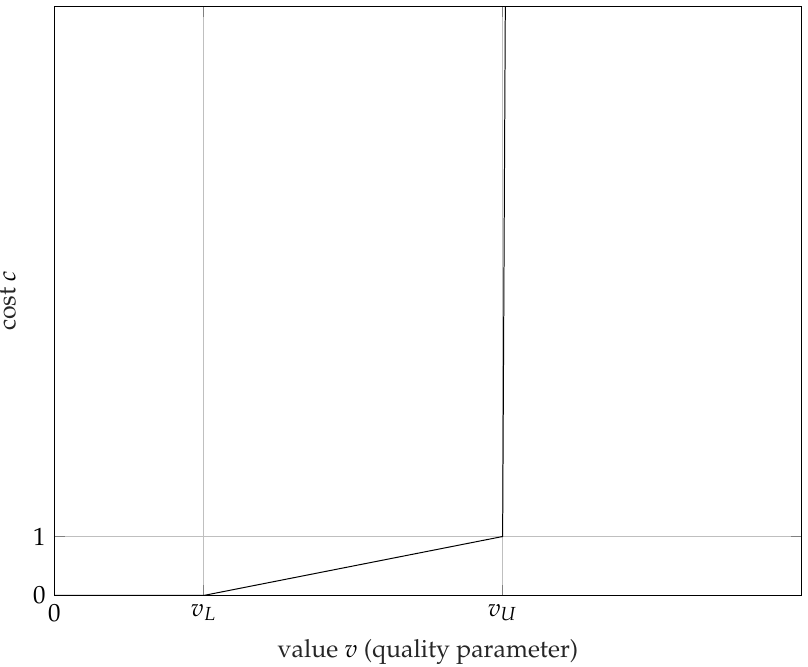
Figure 11. Range-type transfer function used to determine the cost related to the quality